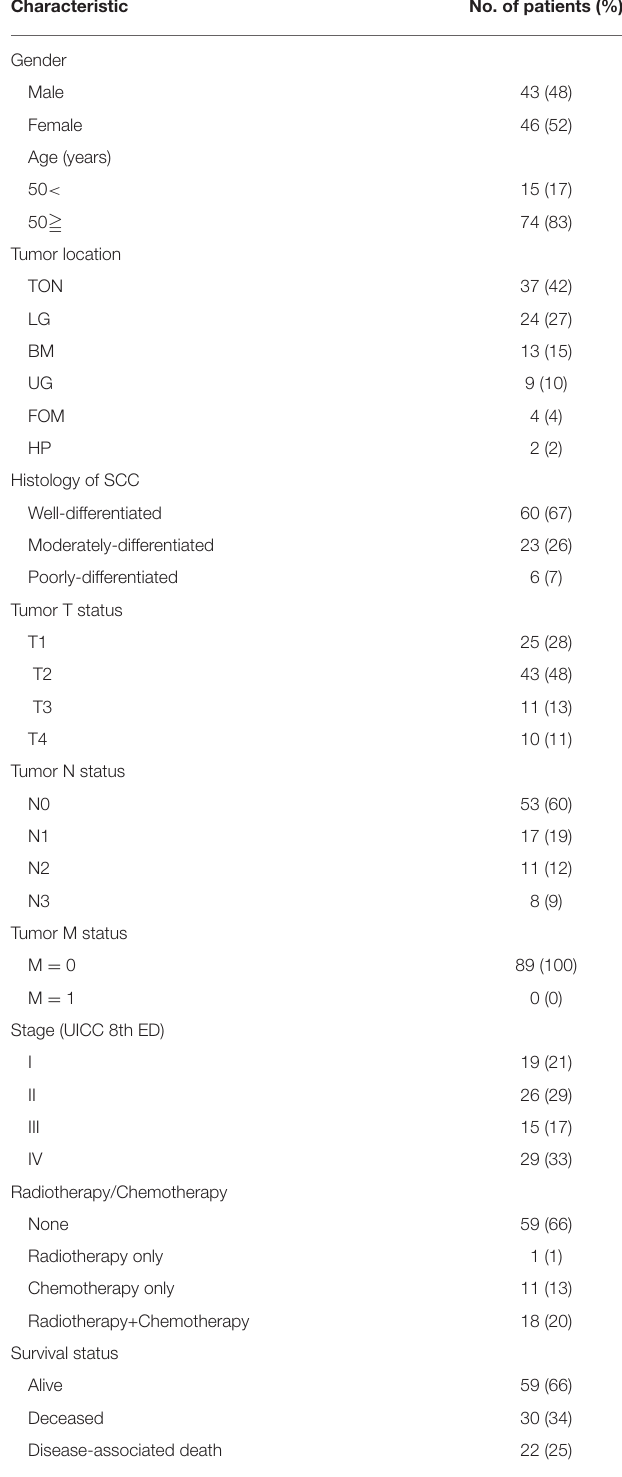
TABLE 1 | Summary of the demographic and clinicopathological characteristics of patients with